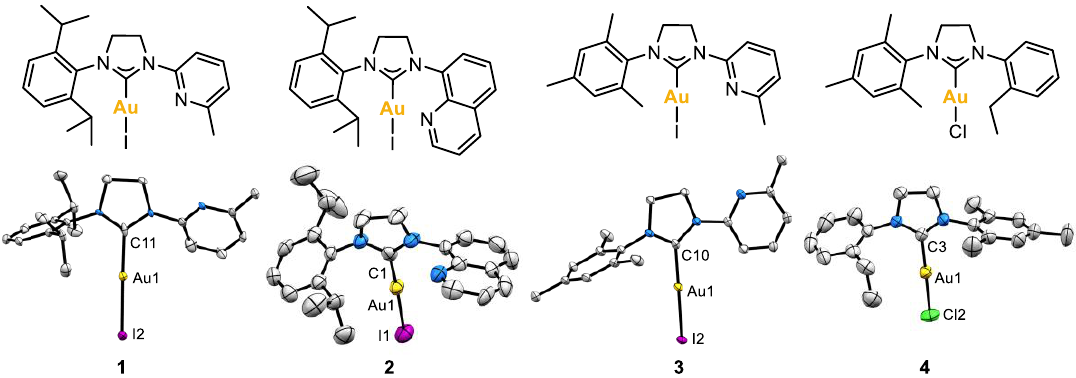
Figure 3. X-ray molecular structures of complexes 1 , 2 , 3 and 4 (ellipsoids set at 50% probability and H atoms removed for clarity). Selected bond distances (Å): for 1 , Au1-C11 2.007(13), Au1-I2 2.5580(10); for 2 , Au1-C1 1.981(9), Au1-I1 2.5467(8); for 3 , Au1-C10 2.000(3), Au1-I2 2.5516(2); for 4 , Au1-C3 1.966(6), Au1-Cl2 2.262(3). Selected angles (°): for 1 , C11-Au1-I2 177.4(4); for 2 , C1-Au1-I1 175.4(2); for 3 , C10-Au1-I2 178.38(8); for 4 , C3-Au1-Cl2 179.12(16).